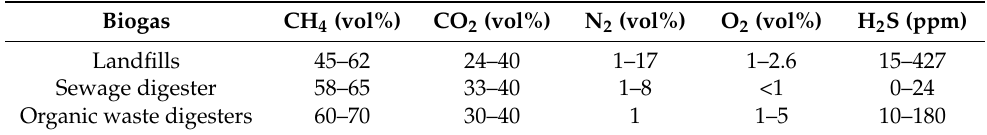
Table 1. Biogas composition depending on raw material [12].